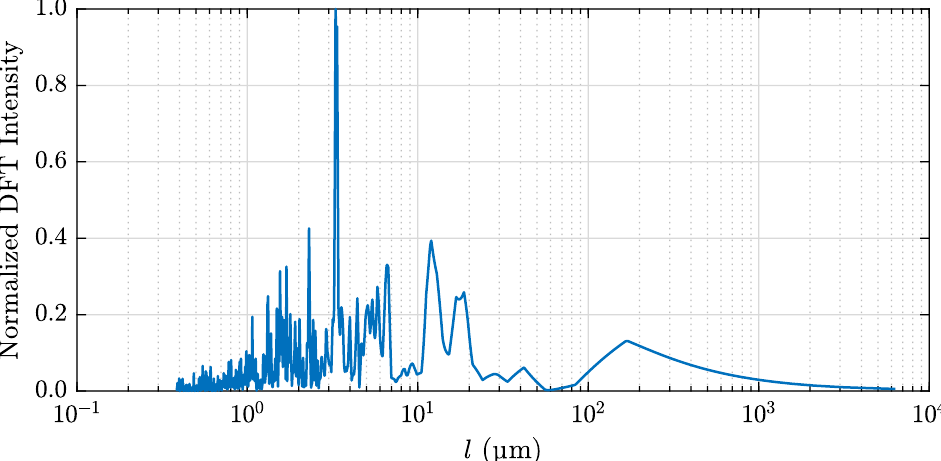
Figure A4. The frequencies along the pronounced line inside the 2D spectrum in Figure A3b are shown. The spectrum is normalized to 1 highlighting the most dominant frequency belonging to a groove distance of